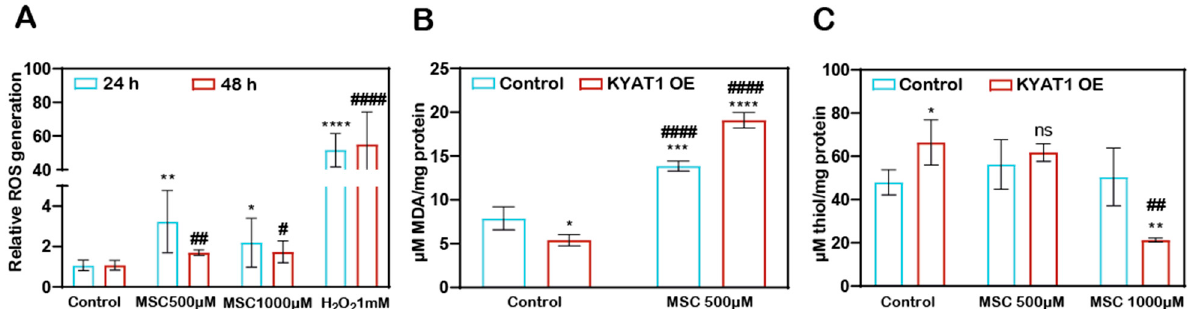
Figure 1. KYAT1 expression and MSC cytotoxicity in cancer and normal human liver hepatocytes. ( A ) MSC cytotoxicity in three different hepatocellular carcinoma cell lines (HEPG2, Hep3B, and Huh7) and freshly isolated human primary hepatocytes at 72 h ( n = 10). ( B ) Transamination activity of KYAT1 in three HCC cell lines and human primary hepatocyte ( n = 10). ( C , D ) Western blot showing the expression and quantification of over-expressed KYAT1 enzyme after 48 h of transfection in HEPG2 cells. 1) control, 2) mock-transfected, and 3) KYAT1-over-expressing plasmid-transfected cells ( n = 4). ( E ) Transamination activity ( n = 10) and ( F ) Beta-elimination ( n = 9–14) activity in control, mock, and KYAT1 over- expressed HEPG2 cell lysate. ( G ) KYAT1 over-expression increases the sensitivity of MSC-mediated cytotoxicity at 72 h in HEPG2 cells ( n = 14). ( C , D ) KYAT1 48kDa and Vinculin 124kDa were used as a loading control and 20 µg of protein from cell lysate was used. ( E – G ) Graph represents mean ± SD, statistical analysis performed with one-way ANOVA with 95% confidential interval followed by Tukey’s multiple comparison test (ns = not significant, * p < 0.05, ** p < 0.01, *** p < 0.001, and **** p < 0.0001 compared with untransfected control and # p < 0.05, ## p < 0.01, ### p < 0.001, and #### p < 0.0001 compared with mock).